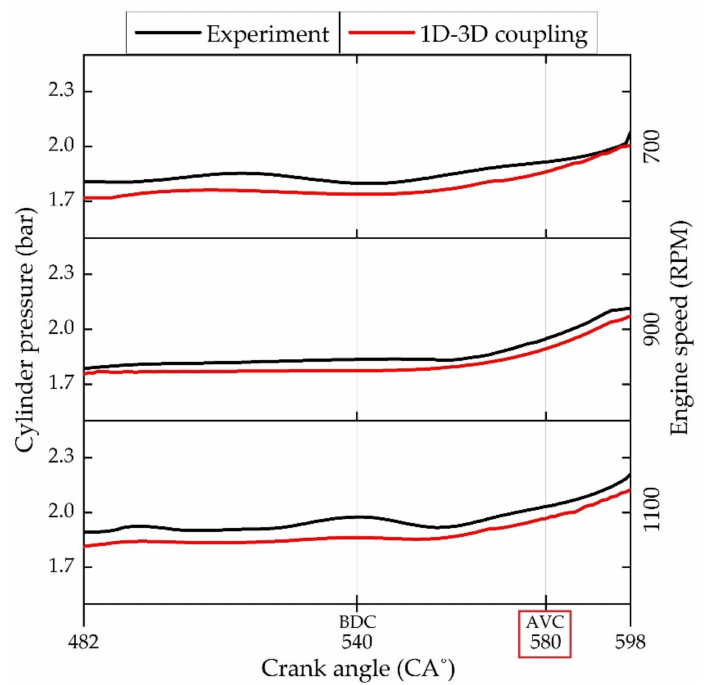
Figure 7. Cylinder pressure results of the 1D–3D coupling gas flow analysis and experiment in the gas exchange process (air-intake valve closing).